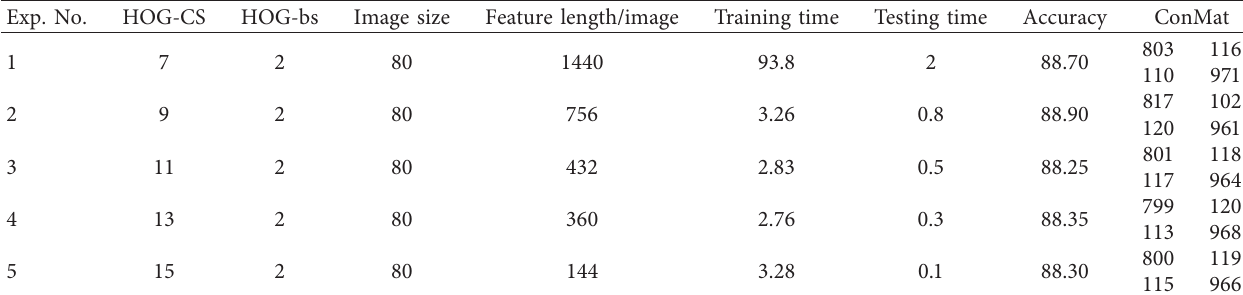
Table 4: HOG and SVM optimized parameters for training and testing with SMO. Exp. No.